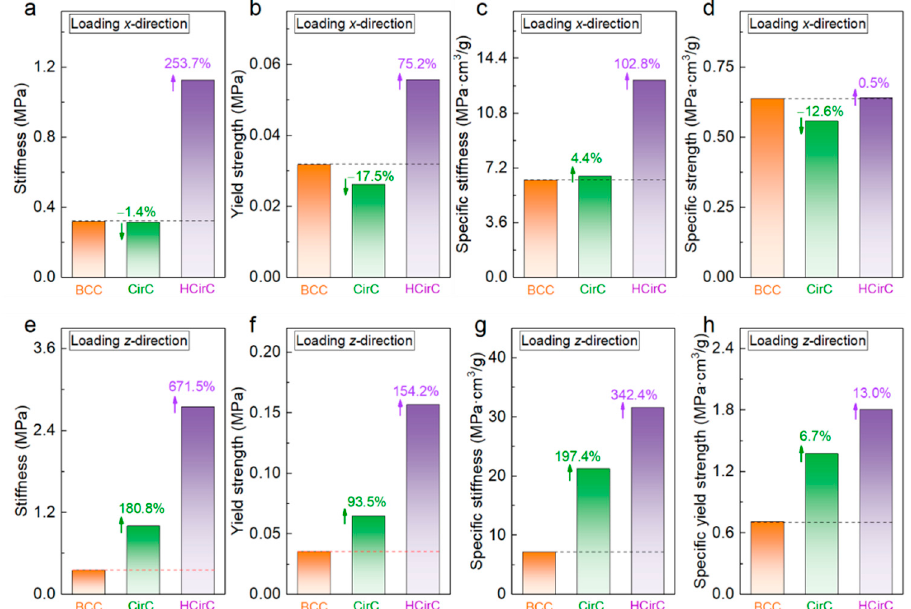
Figure 9. The compression mechanical properties of lattice structures BCC, CirC, and HCirC: ( a – d ) compression along the x -axis; ( e − h ) compression along the z -axis.